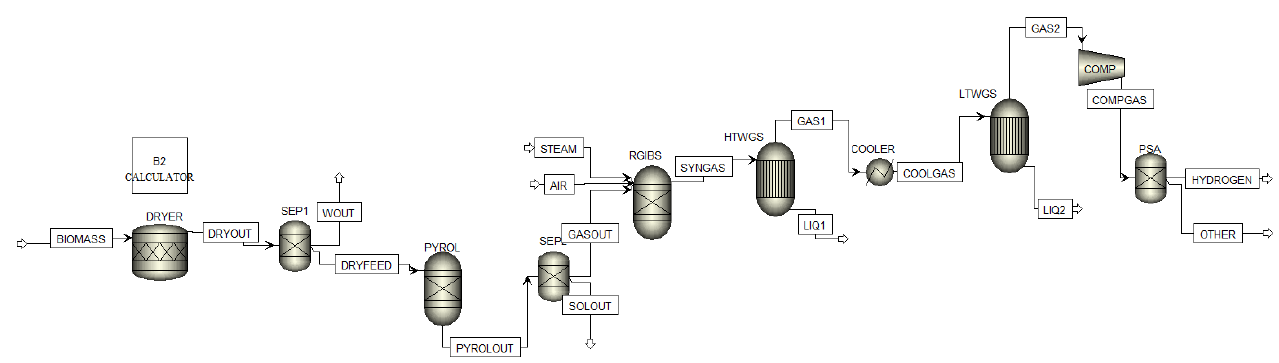
Figure 1. Scheme of the simulated system by Aspen Plus.